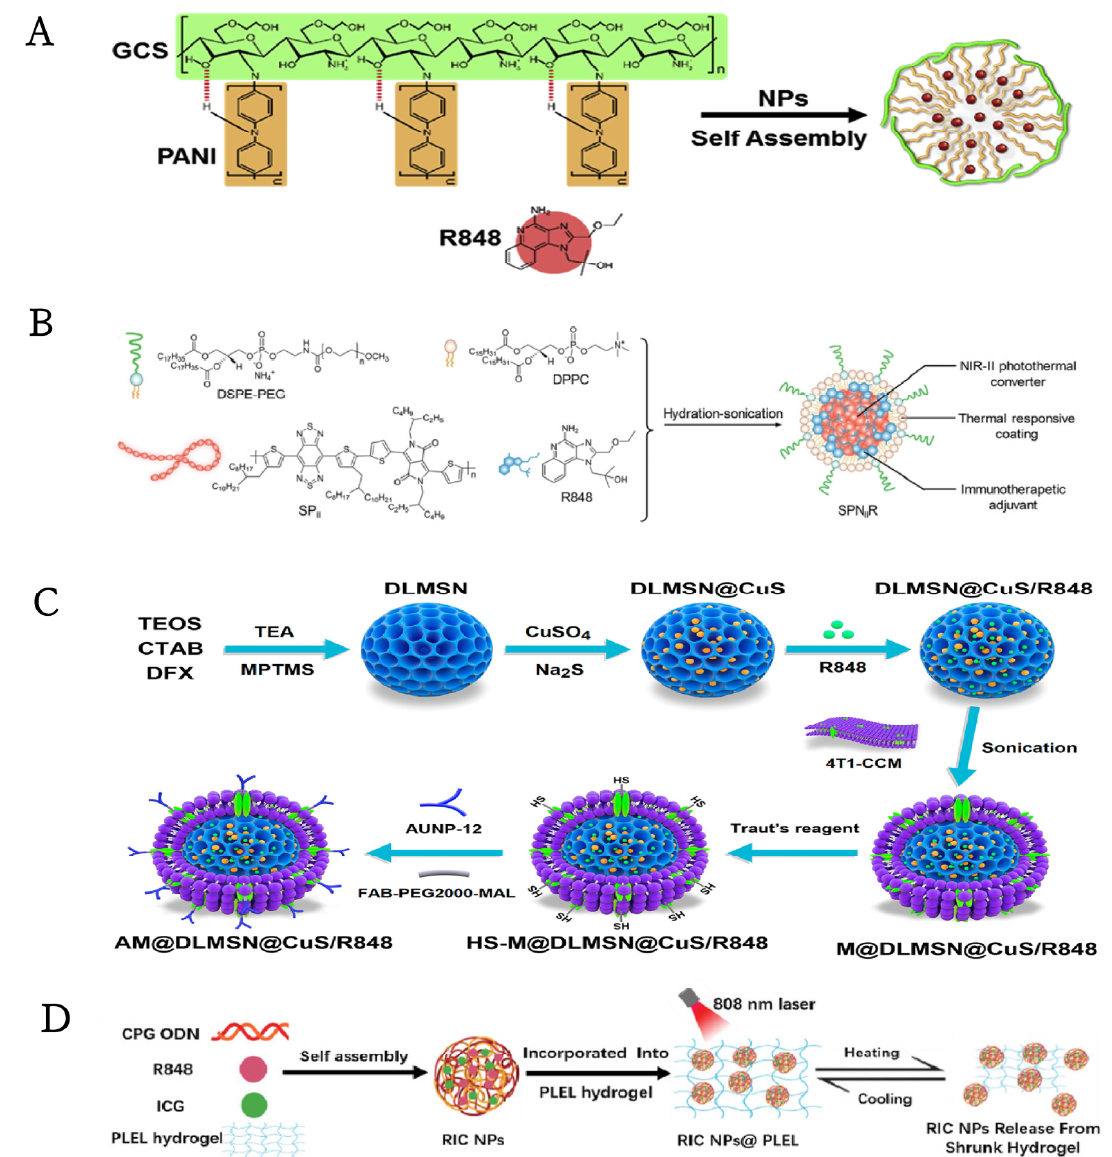
Figure 4. ( A ) Composition/structure of R848@NPs. Reprinted with permission from Ref.